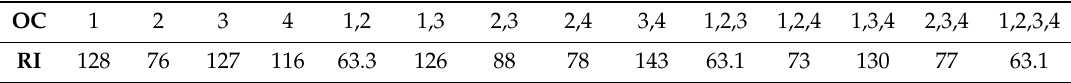
Table 6. System Operation Sensitivity.